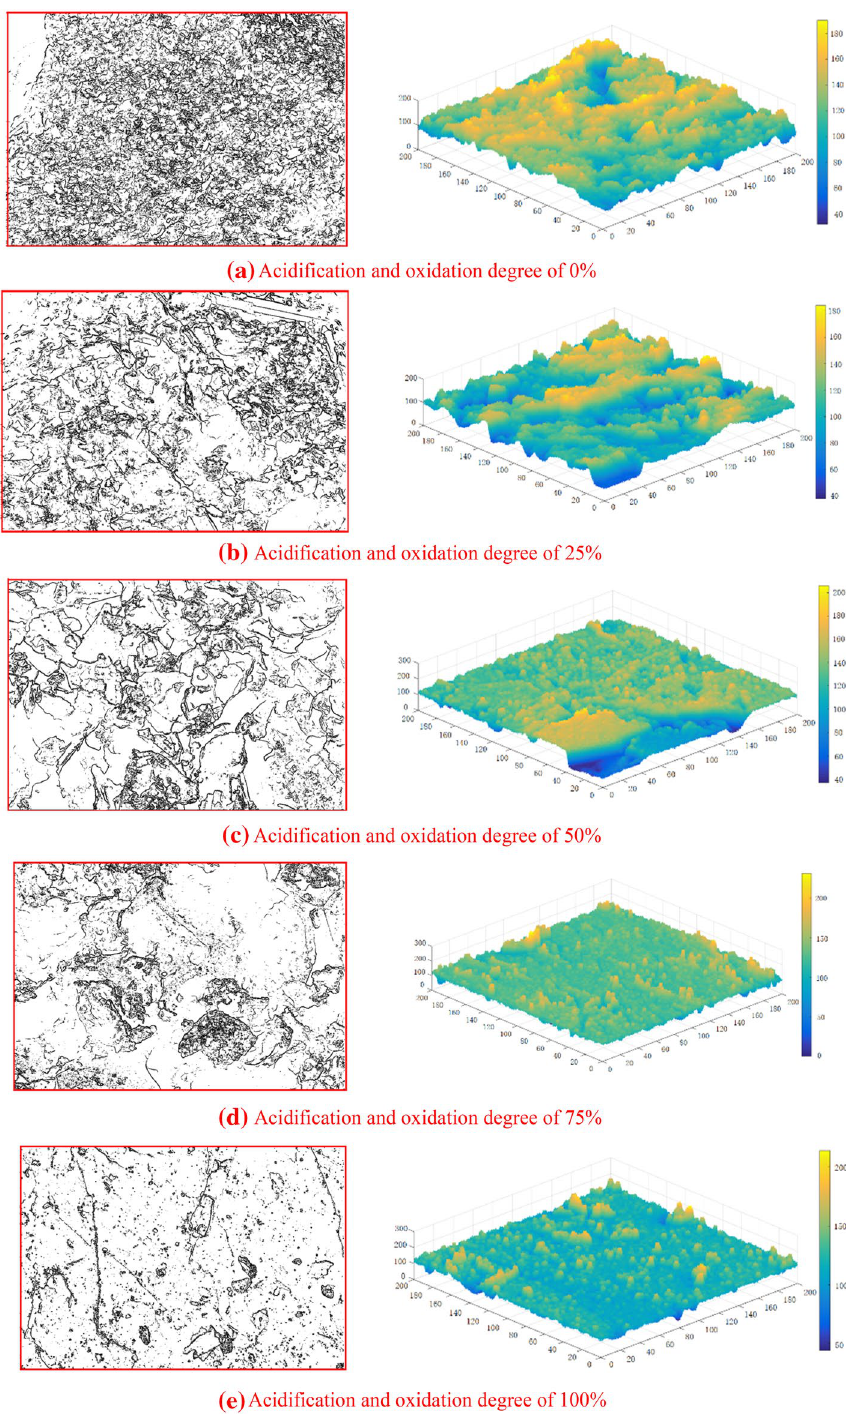
Figure 5. The Binary image and Microscopic 3 D structure of micro-fracture surfaces of tailing sand under different oxidation and acidification